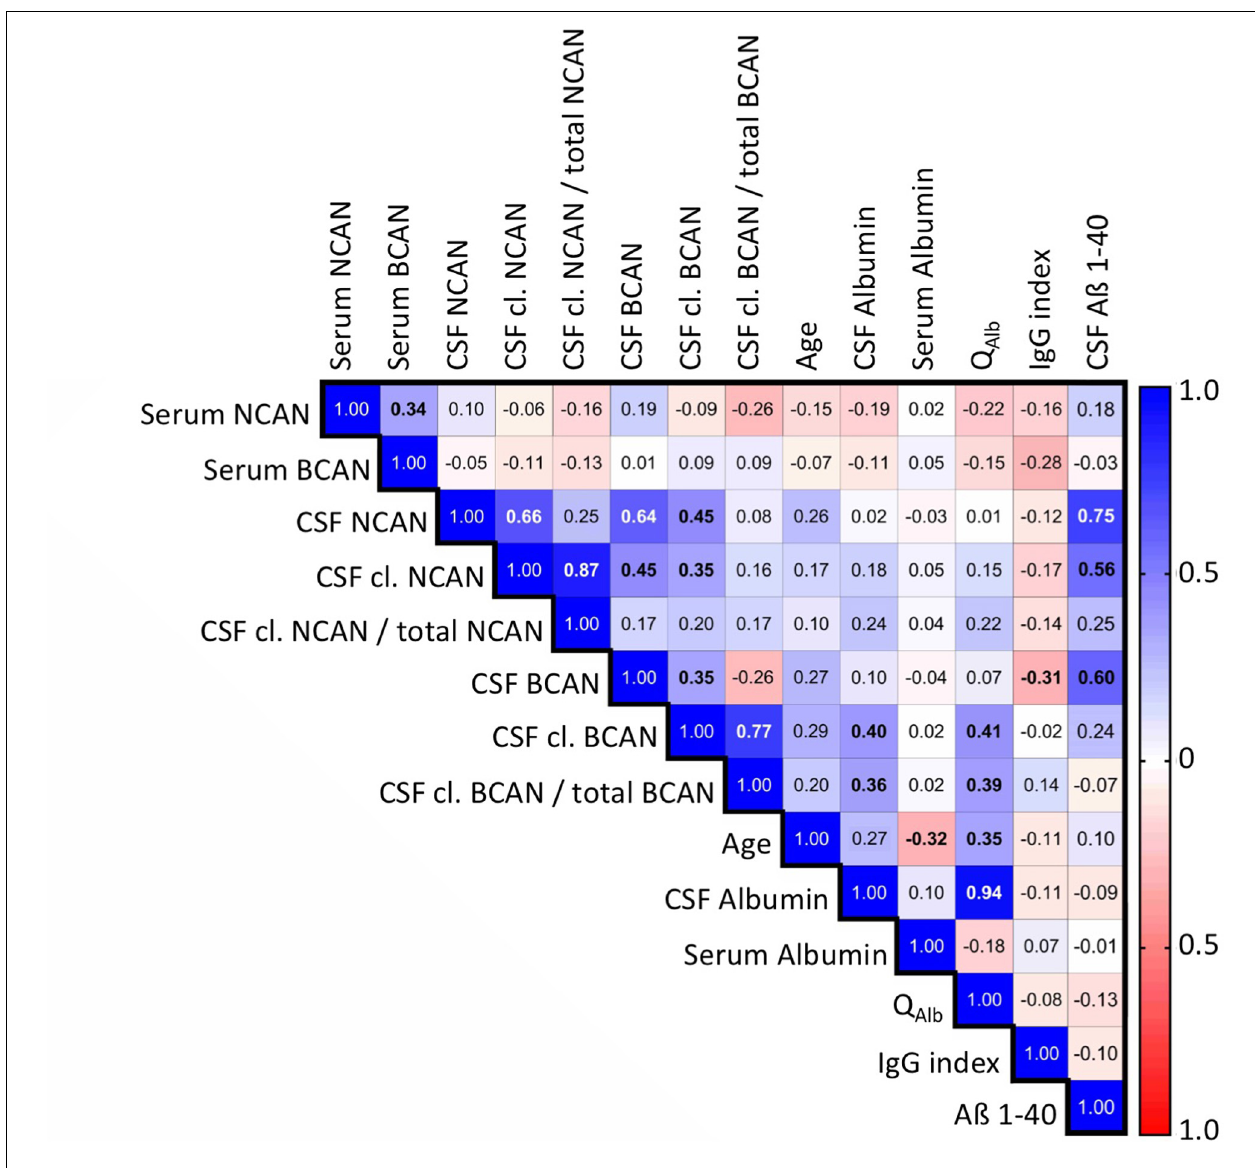
r ρ = 0.90, p < 0.001; Figure 5B ). No significant differences were found within the CSVD subgroups (CAA versus HA) for cleaved neurocan and cleaved normalized to total neurocan levels (all t s ≤ 0.64, ps ≥